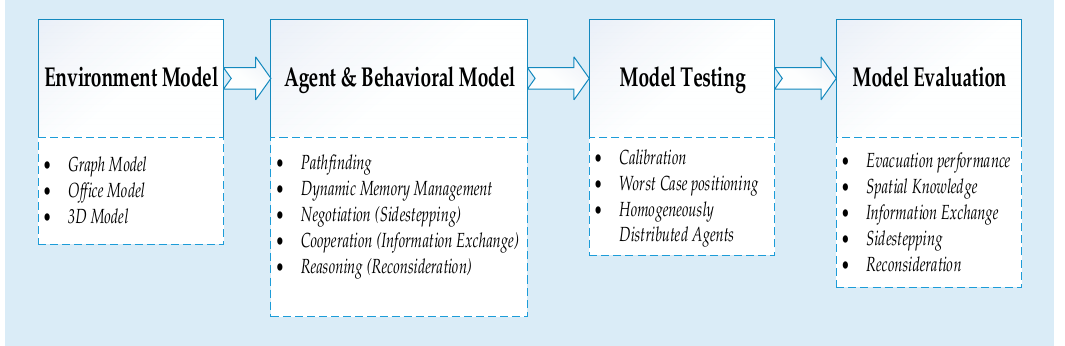
Figure 1. Overall process diagram of hierarchical behavior model of the study.